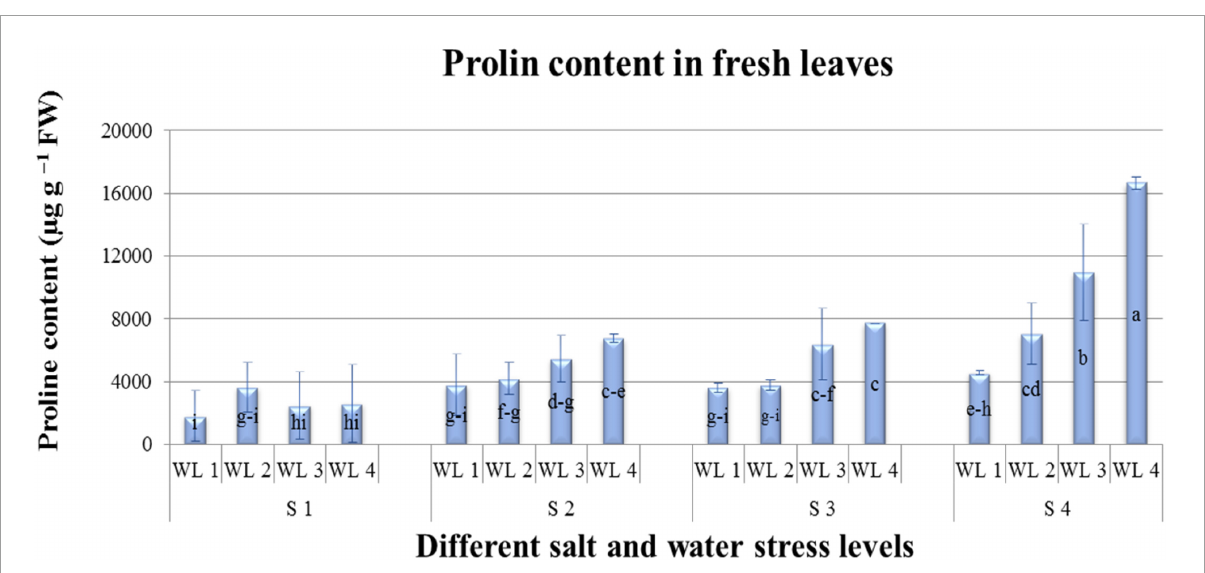
FIGURE5 Interactive effect of salinity and drought stress on Proline content ( µ gg − 1 FW) content of Atriplex leucoclada . Error bars represent standard error of the mean ( n = 3). WL stands for water level (WL1 = 100% field capacity, WL2 = 80% field capacity, WL3 = 60% field capacity and WL4 = 40% field capacity) while S represents salinity (S1 = 5 dS m − 1 , S2 = 10 dS m − 1 , S3 = 15 dS m − 1 , and S4 = 20 dS m − 1 . Letters a–i indicate whether the bar graphs showing parameters are significant or nonsignificant. Bars having the same letters are